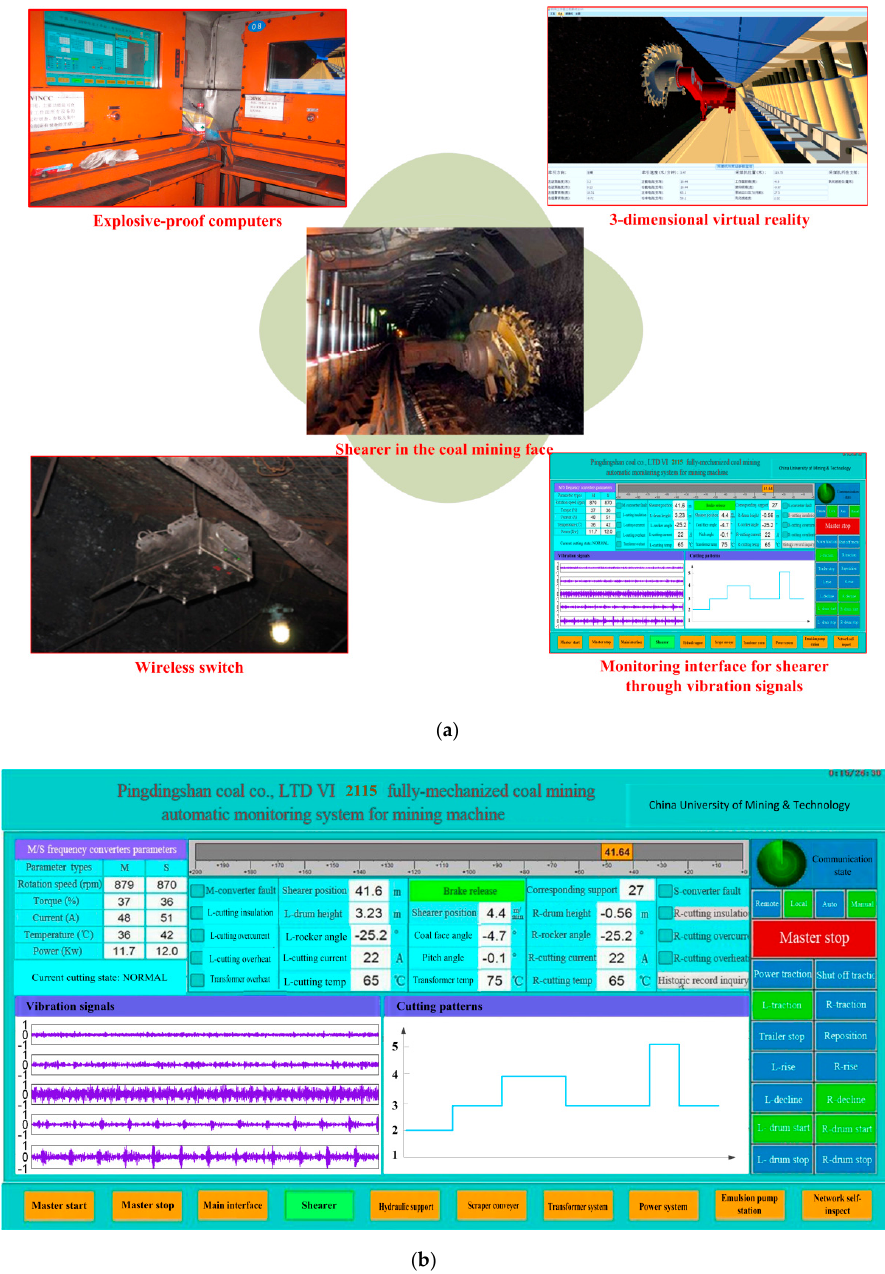
Figure 12. Basic structure of the system for industrial test in the coal mining face: ( a ) The system in coal mining face based on proposed method; ( b ) The monitoring interface for shearer.